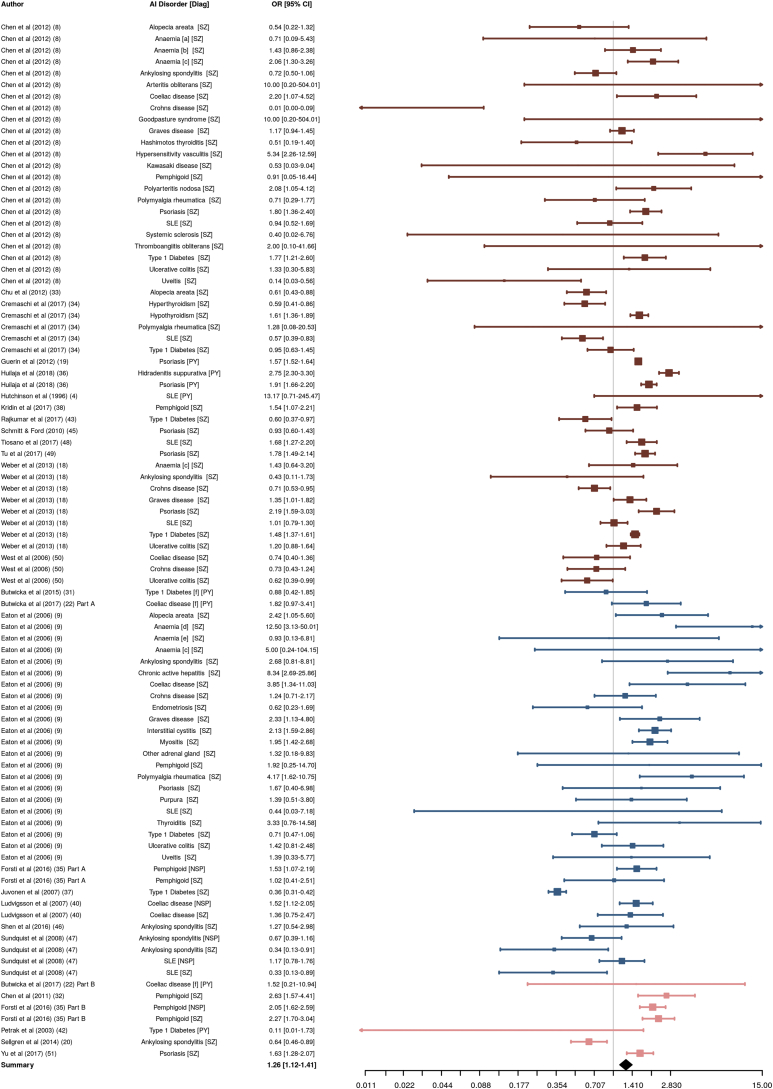
Results of overall meta-analysis for all non-neurological autoimmune disorders (except rheumatoid arthritis) and psychosis. Marker and line colors indicate study design: type A (red), type B (blue), type C (pink). AI, autoimmune; CI, confidence interval; Diag, psychiatric diagnosis; HSV, hypersensitivity vasculitis; NSP, nonschizophrenia psychosis; OR, odds ratio; PY, psychosis; SLE, systemic lupus erythematosus; SZ, schizophrenia. aAutoimmune hemolytic type. bHereditary hemolytic type. cPernicious type. dAcquired hemolytic. eOther hereditary hemolytic type. fChildhood-onset.